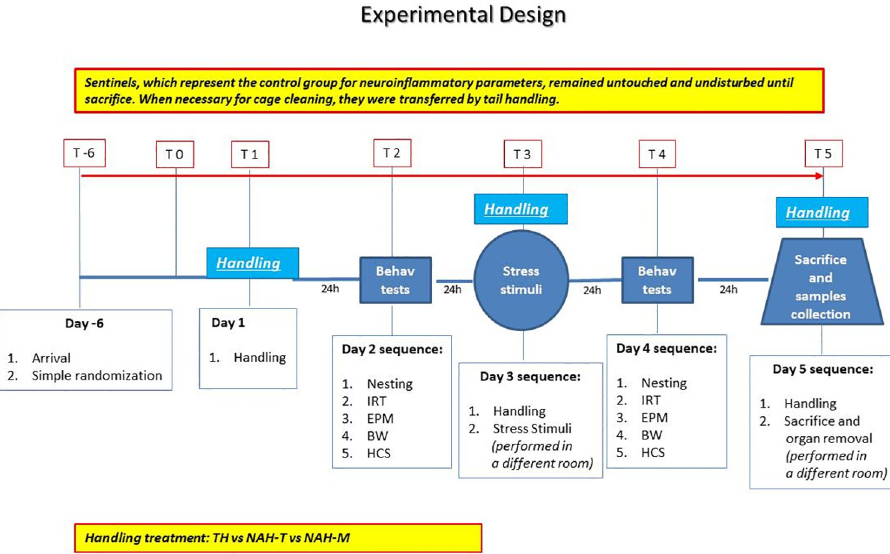
day. The hour before stress stimuli, animals received a session of handling. The 4 th day, 24 hours after stress, post-stress behavioural tests were performed and the last day, after another handling session, mice were sacrificed and organ collected. The entire study lasted 3 weeks, repeating the complete test 3